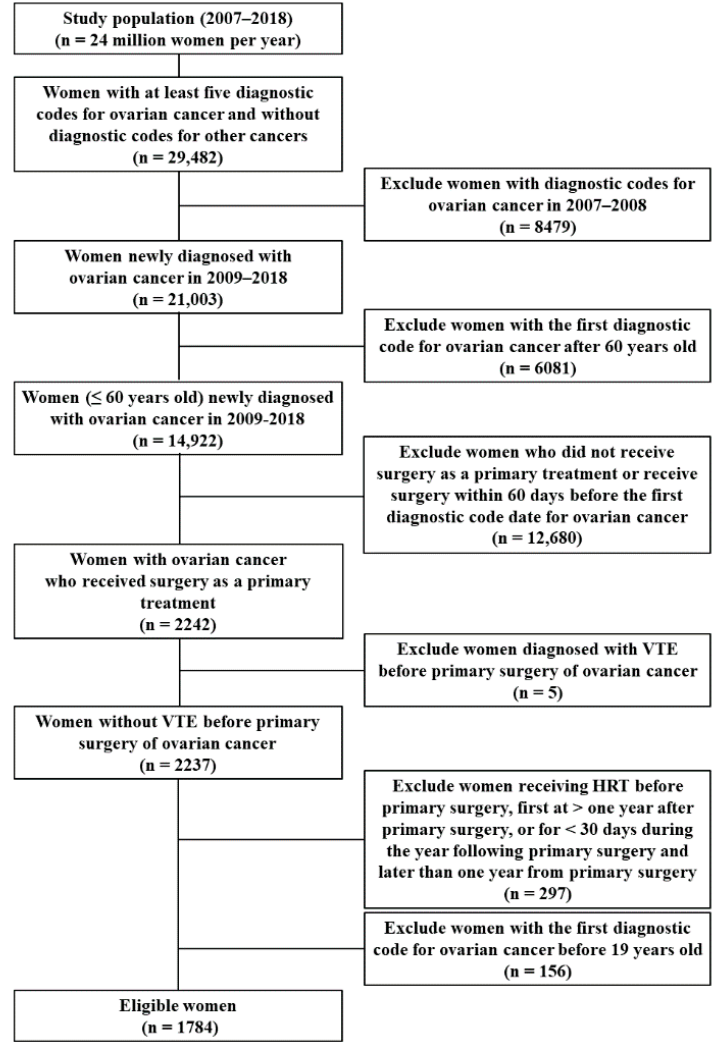
Figure 1. Flow chart of study subject selection.